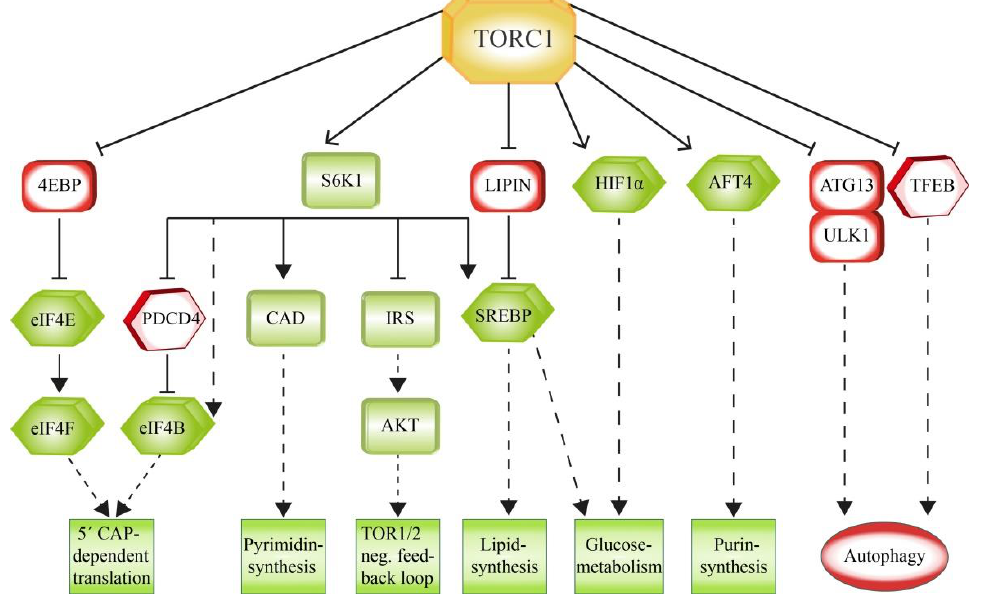
Figure 4. Downstream effectors of TORC1. The direct phosphorylation of targets by TORC1 has context-dependent results. Factors that interfere with the aims of TORC1 function are inactivated by phosphorylation, while supportive factors are stimulated by TORC1. Factors directly involved in transcription and translation are marked with hexagonal boxes.